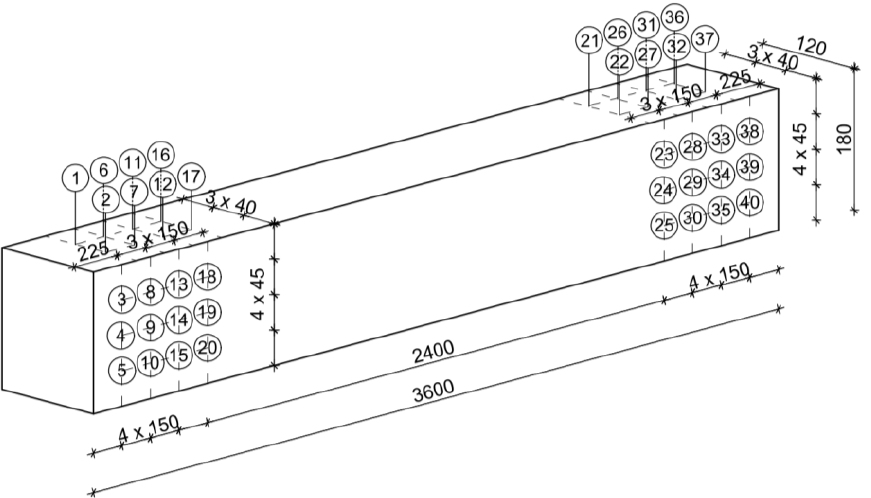
Figure 6. Diagram of the location of drilling points, unit: [mm].